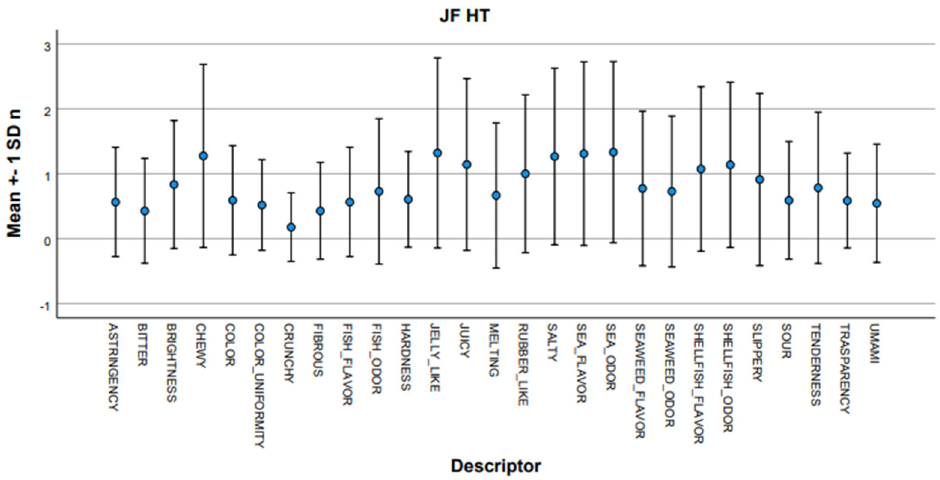
Figure 5. Error bar of the intensity mean score for descriptors selected for sample JF-HT. Bars rep-